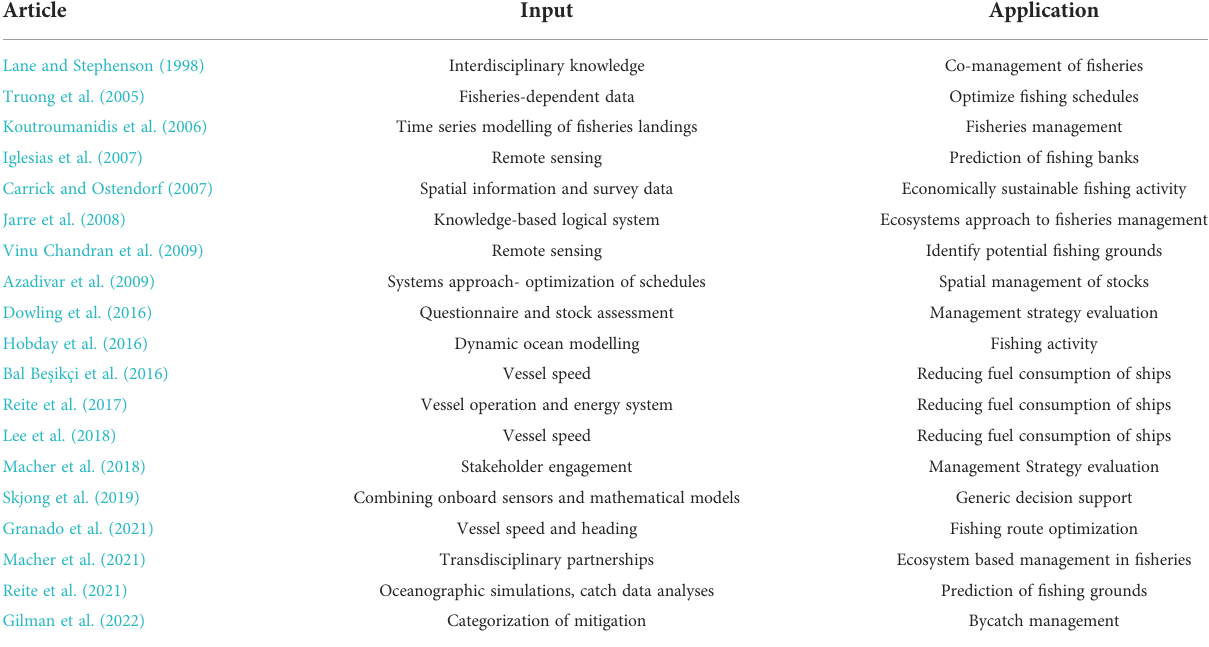
TABLE 1 A selection of literature sorted chronologically on decision support in fi sheries and shipping, describing the input used and the area of